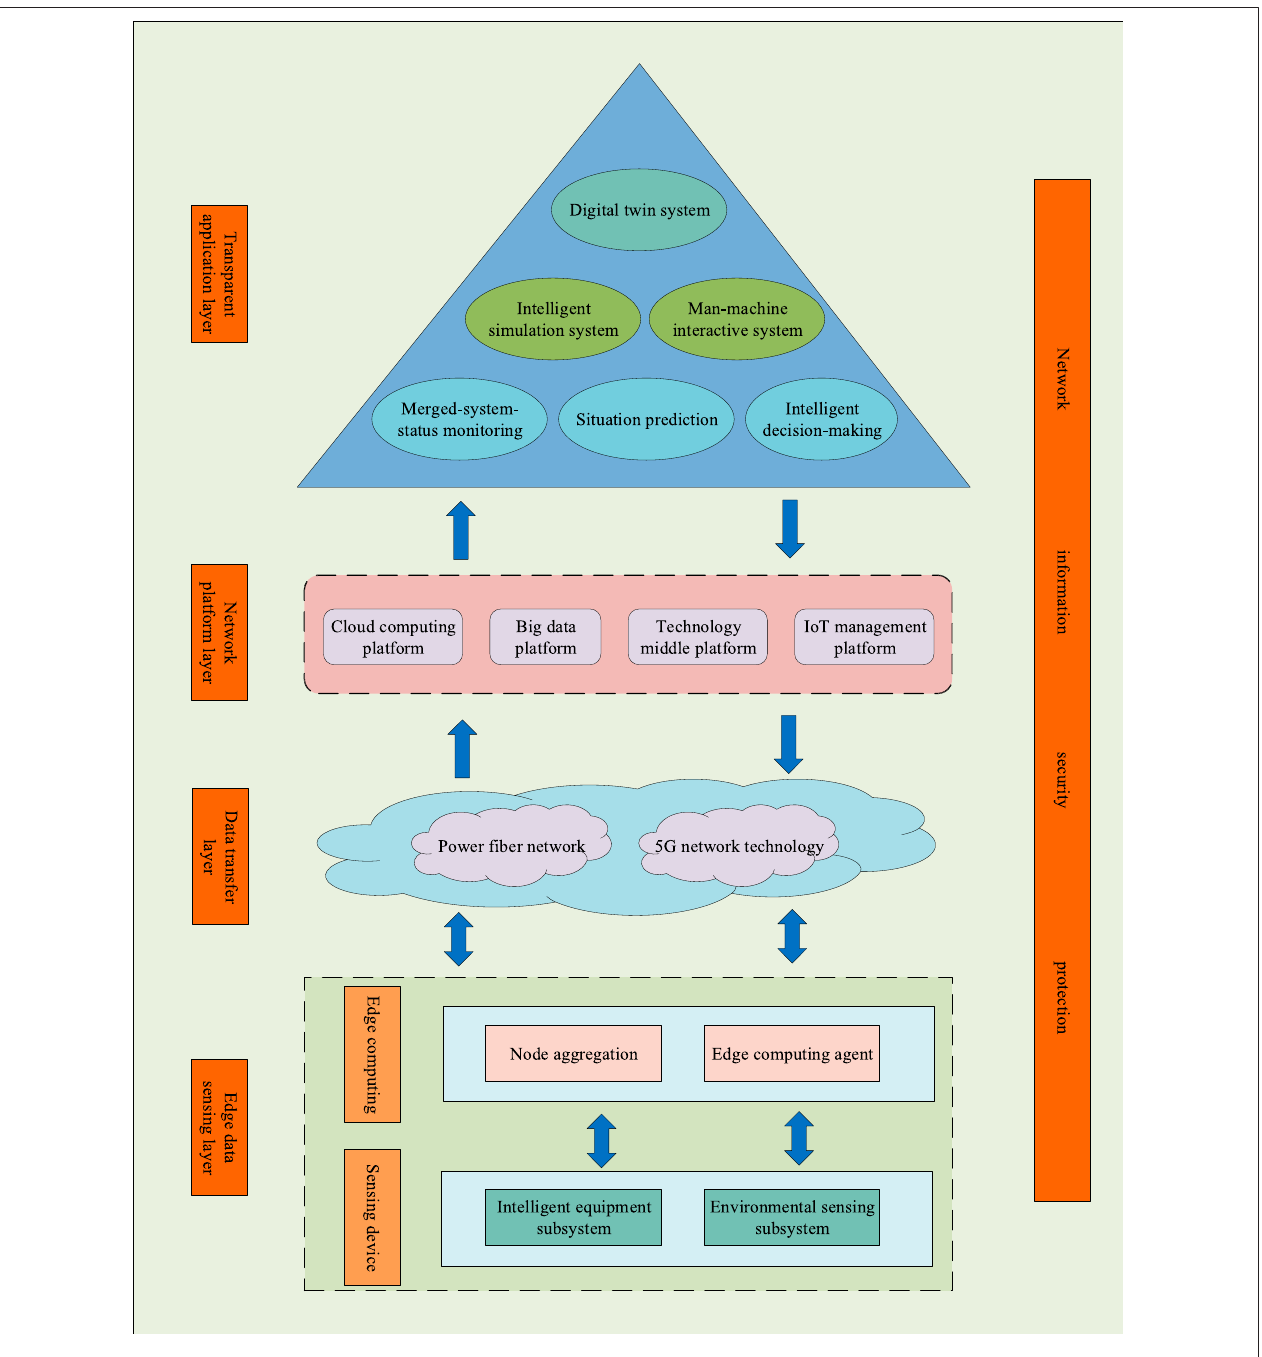
FIGURE 1 | Overall framework of transparent power distribution